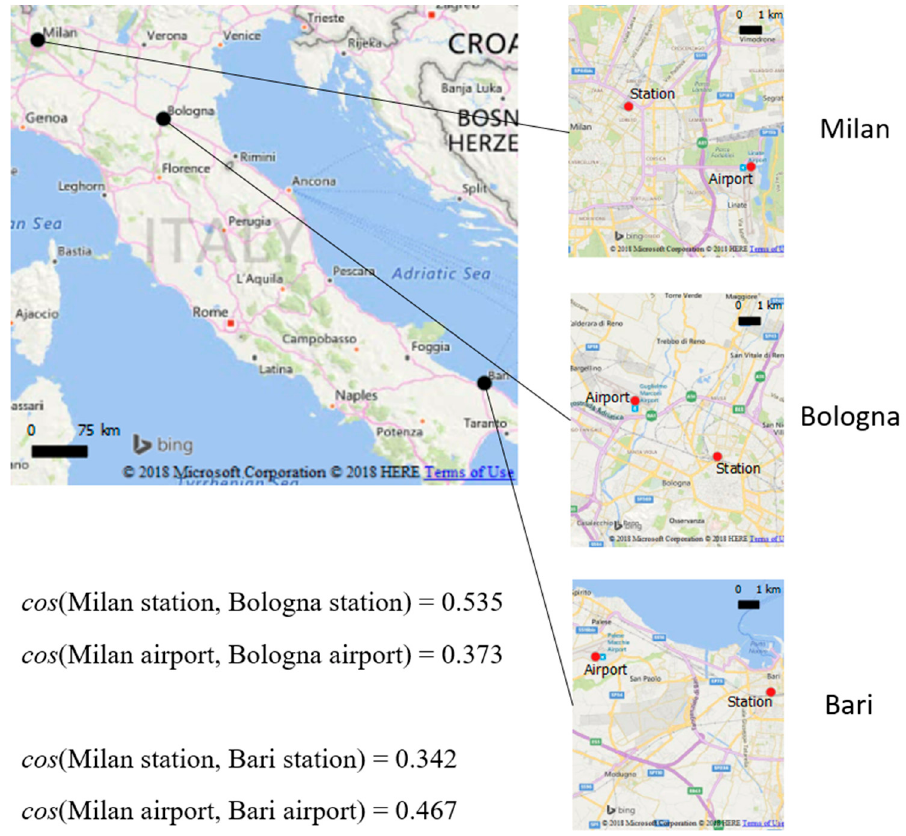
Figure 11. Similarity relationships between airports and stations of three different cities. The example suggests a tendency of traveling by train between Milan and Bologna, and by plane between Milan and Bari.